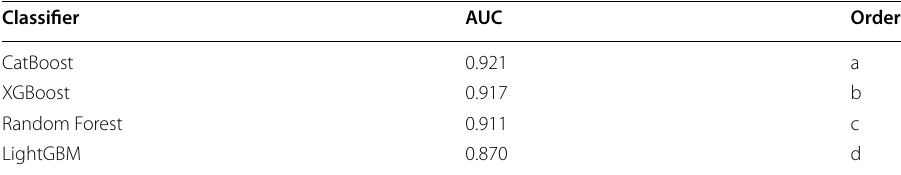
Table 16 Tukey’s HSD results for AUC: classifier factor Classifier